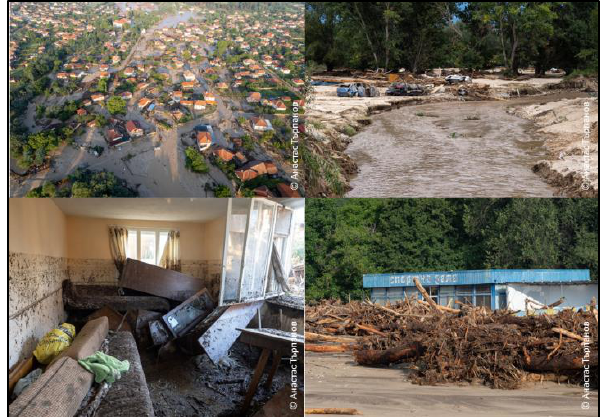
Figure 2 . The damage caused by the flood after September 2, 2022. Karavelovo village the day after the flood ( top left ); Multiple cars swept away in affected areas (top right ); Home in mud has reached ( bottom left ); The stadium of the village of ( bottom right ). © Анастас Търпанов/ Anastas Turpanov (credit:https://www.dnevnik.bg/photos/2022/09/07/4388097_fot ogaleriia_sled_potopa/ – accessed on 21 February 2023.)